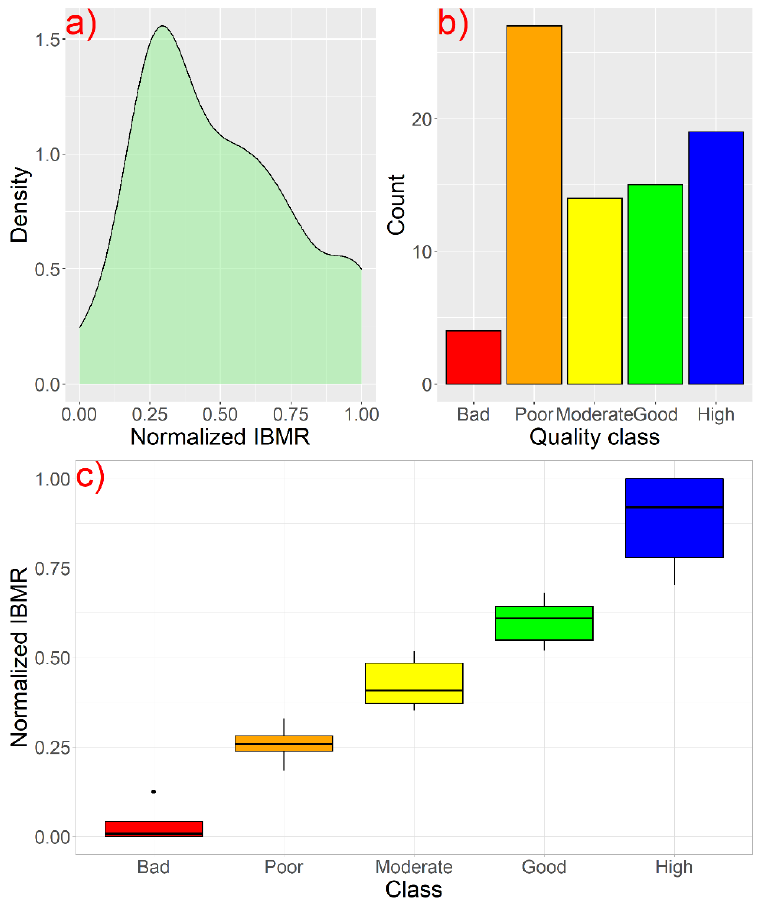
Figure 6. ( a ) Distribution of the normalized IBMR GR and ( b ) histogram of the ecological quality classes for all the studied reaches. Both plots show a high frequency of low values of normalized IBMR GR and Poor ecological quality. More than half of the river reaches have failed the Good ecological quality threshold. Subplot ( c ) shows boxplots of the normalized IBMR per class of ecological quality.